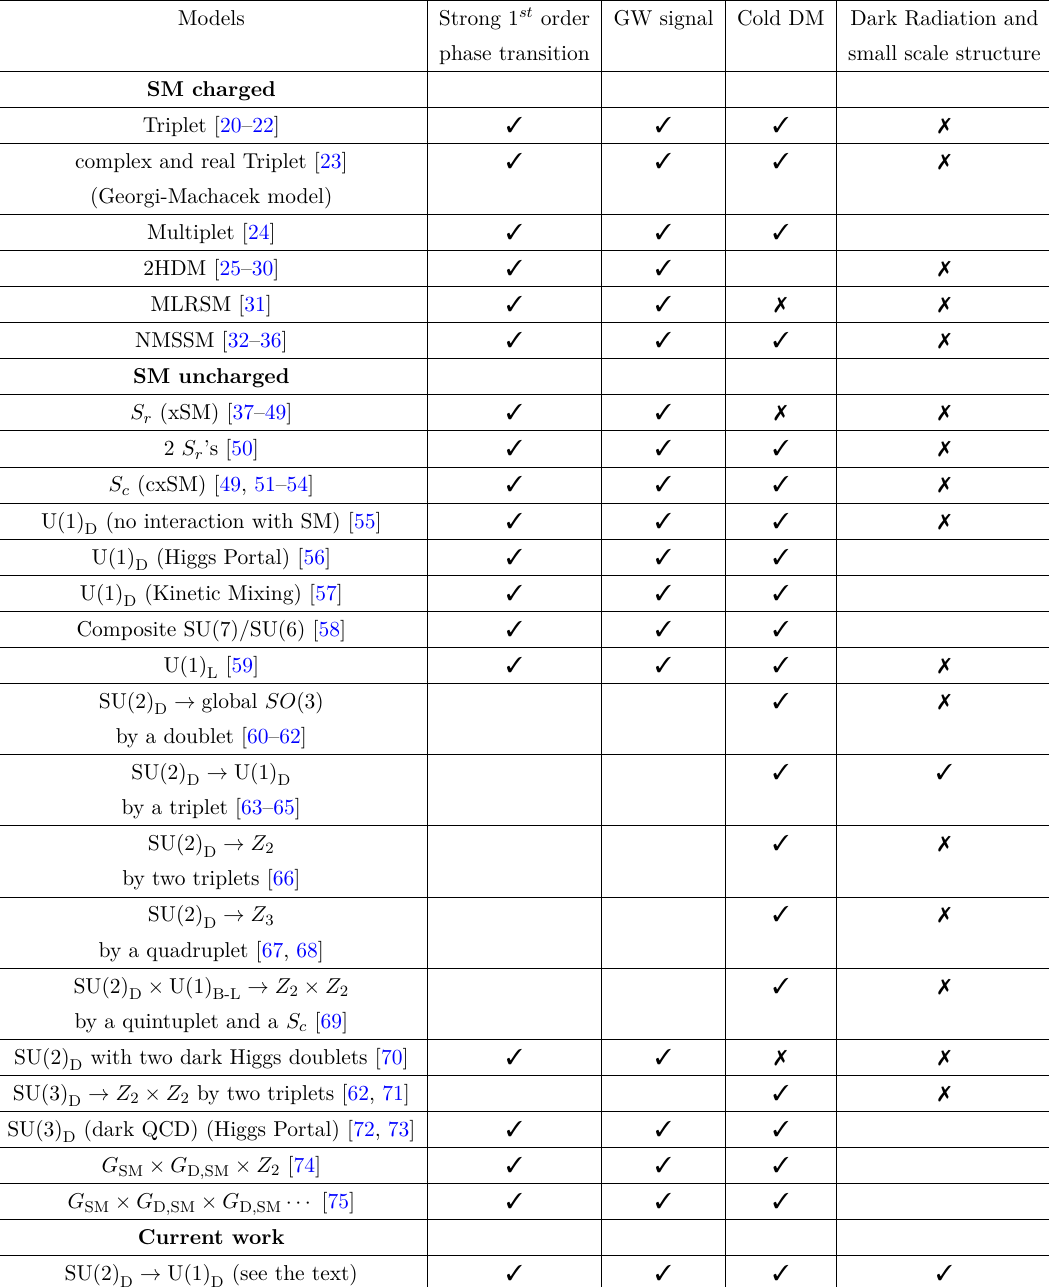
Table 1. Theoretical models and their implications of EWPT, detectable GW signals, cold DM candidates, existence of DR and the small-scale structure. Models successful in fulfilling (not fulfilling) the desirable features are marked by checks